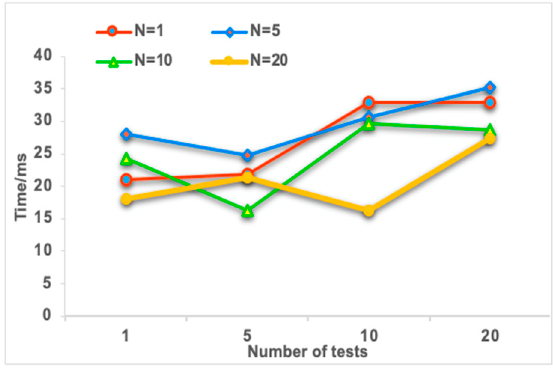
Figure 6. Analysis of verify certificate performance from blockchain.